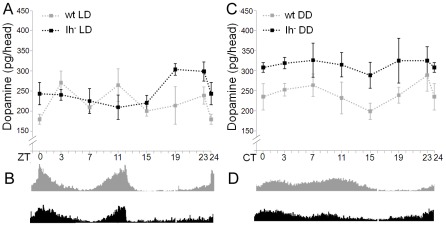
Lack of Ih current alters dopamine levels.Dopamine and activity was measured in 6 to8 days old flies at day 3 or 4 in each condition. Error bars indicate SEM. (A) In LD conditions, DmIh mutant flies (black dotted line) lose the characteristic cyclic pattern of dopamine at daytime, and show a notable increase in dopamine levels at night time. To facilitate comparison, dopamine in control flies is displayed with a gray dotted line. (B) Correspondingly, total activity plot of mutant flies (n = 31; bottom black actogram) reveals subtle changes in the circadian locomotor activity when compared with control flies (top gray actogram): activity peak at lights on looks wider and blunted, while peak at lights off ends abruptly. In addition, mutant flies show increased activity during the night compared to control flies. (C) In DD conditions, the level of dopamine in DmIh mutant flies (black dotted line) increases drastically throughout the 24 hour period when compared to control flies (gray dotted line). (D) Total daily activity plot of mutant flies (n = 53; bottom black actogram) shows that activity during the second half of the subjective day is reduced compared to control flies (top gray actogram).